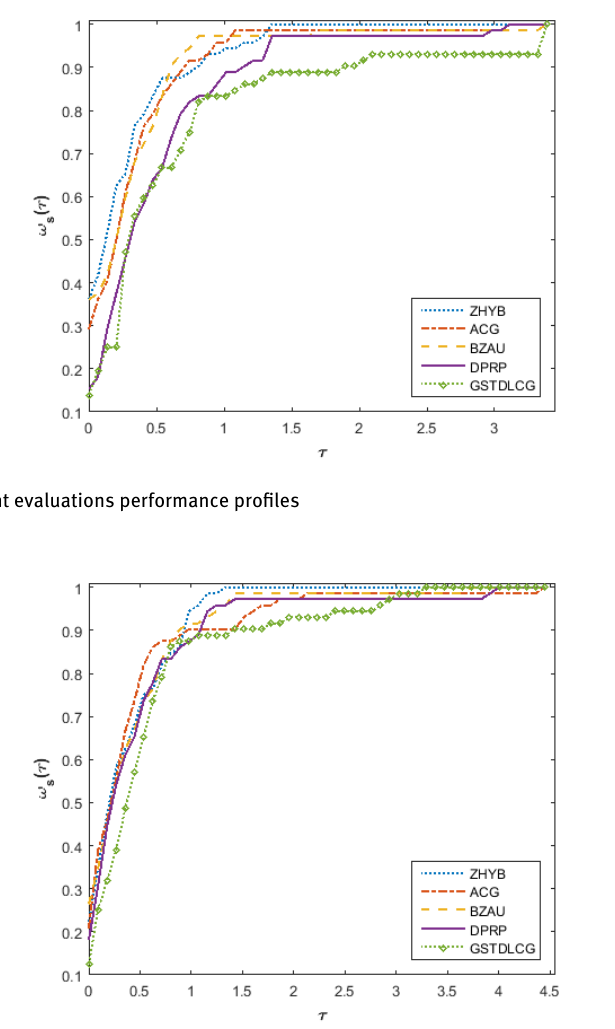
Figure 4: CPU time performance